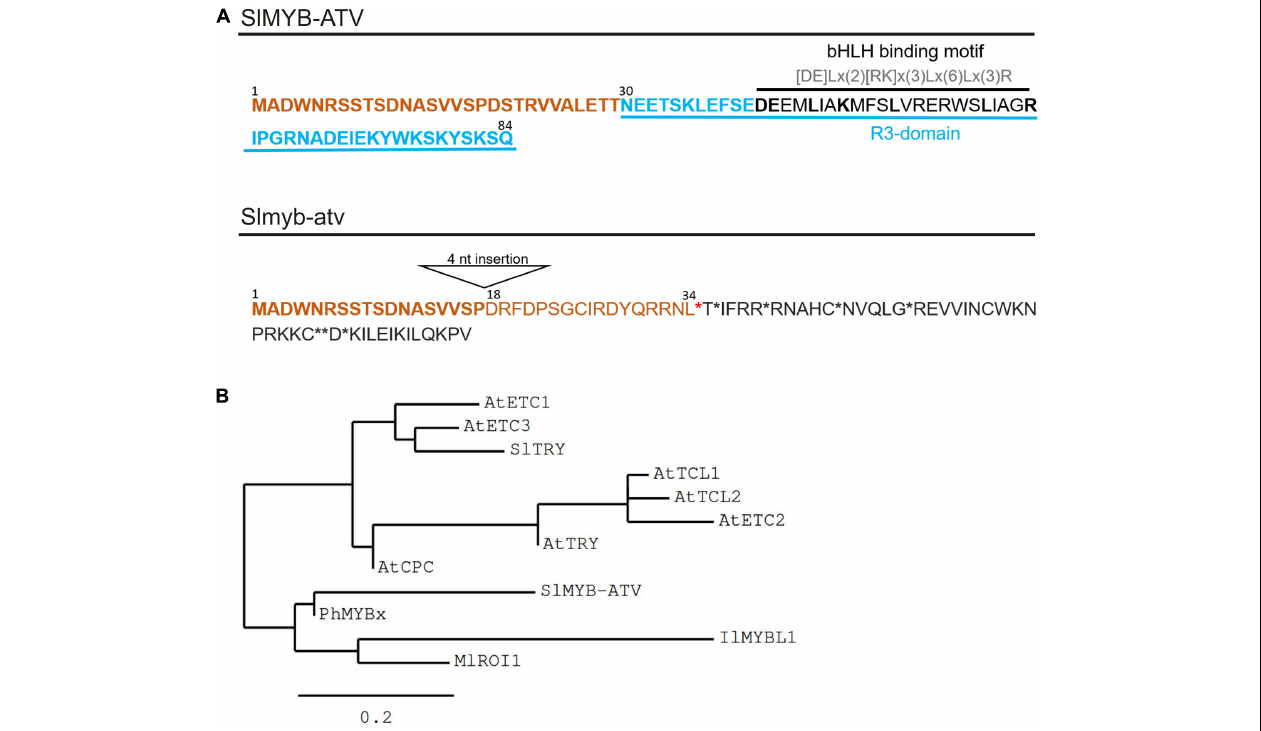
FIGURE 3 | Main features of the SlMYB-ATV mutated protein. (A) Predicted protein sequences as result of the translation of the wild type (wt) allele (SlMYB-ATV) and of the atv allele (Slmyb-atv) of Solyc07g052490 . N-terminal common aminoacids are marked in bold orange. In the wt version of the polypeptide, the R3 domain, containing the bHLH interaction motif, is indicated. In the atv version of the protein the position of the 18th amino acid, the first different from wt due to the 4 nucleotide (nt) insertion in the corresponding gene, is indicated. Stop codons are indicated by asterisks. (B) Phylogenetic tree showing the relatedness of SlMYB-ATV with other known plant R3-MYB proteins. The analysis was performed on the phylogeny.fr platform (Dereeper et al., 2008), using the maximum likelihood method (PhyML Program) and reliability for internal branch was assessed using the aLRT test (SH-Like). Graphical representation of the phylogenetic tree was performed with TreeDyn. Protein sequences were identified on the NCBI website and the relative GeneBank accession numbers are as follows: AtETC1 (OAP16560), AtETC2 (Q84RD1), AtETC3 (NP_192015), AtTCL1 (D3GKW6), AtTCL2 (B3H4X8), AtCPC (BAA21917), AtTRY (Q8GV05), SlTRY (MF197521), SlMYB-ATV (MF197509), PhMYBx (AHX24371), IlMYBL1 (ASR83103.1), MlROI1